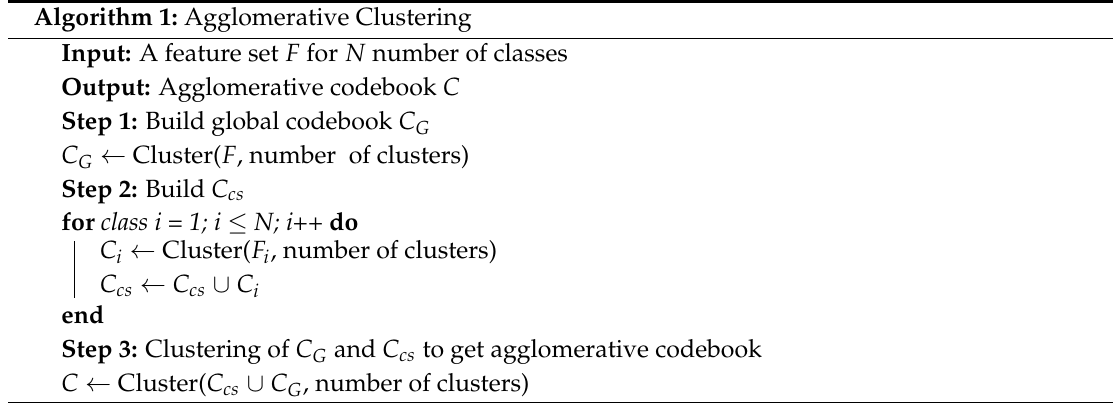
Algorithm 1: Agglomerative